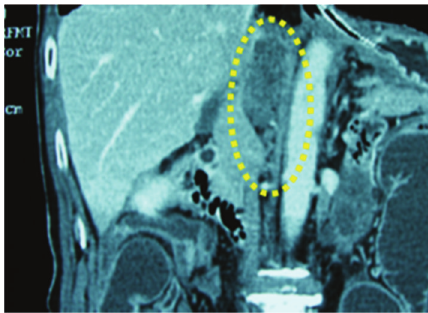
Figure 10: Coronal enhanced CT scan shows tumor located between the inferior vena cava, caudate lobe, and left crus of diaphragm.